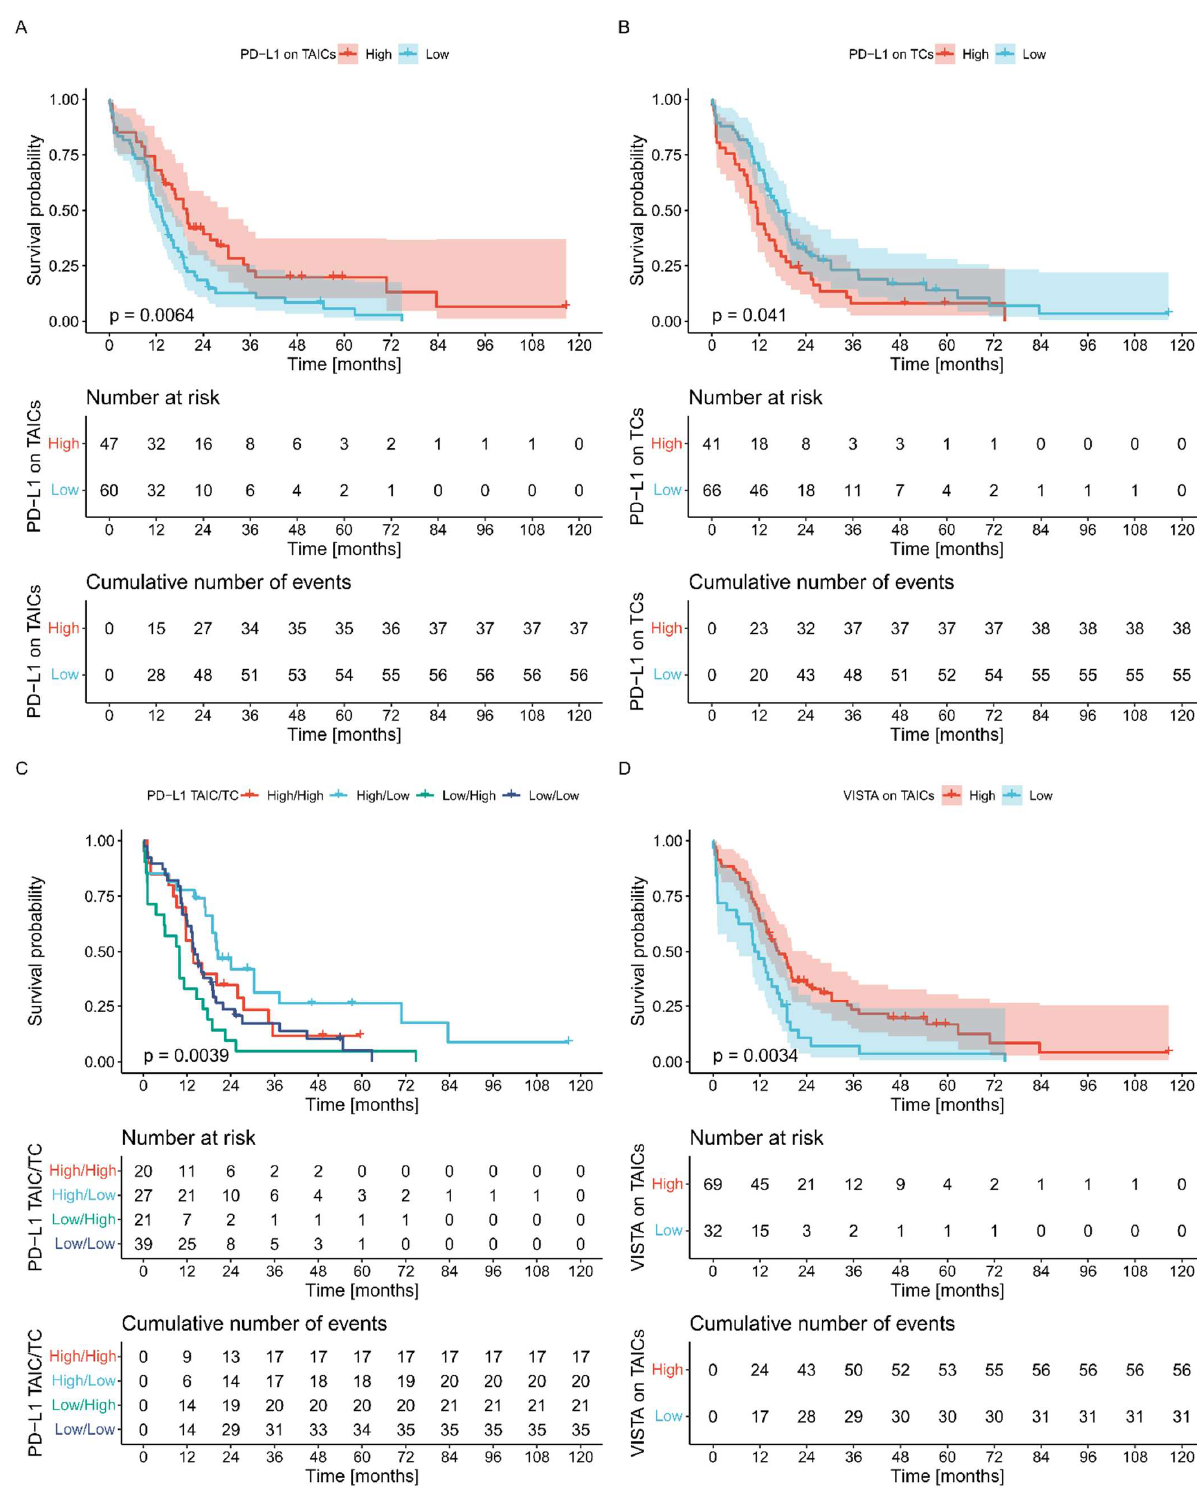
Figure 4. The Kaplan–Meier plots for OS stratified by PD-L1 on TAICs ( A ), PD-L1 on TCs ( B ), com- bined PD-L1 on TAICs/TCs ( C ), and VISTA on TAICs expression ( D ) in pancreatic adenocarcinoma. p -values were calculated with log-rank.